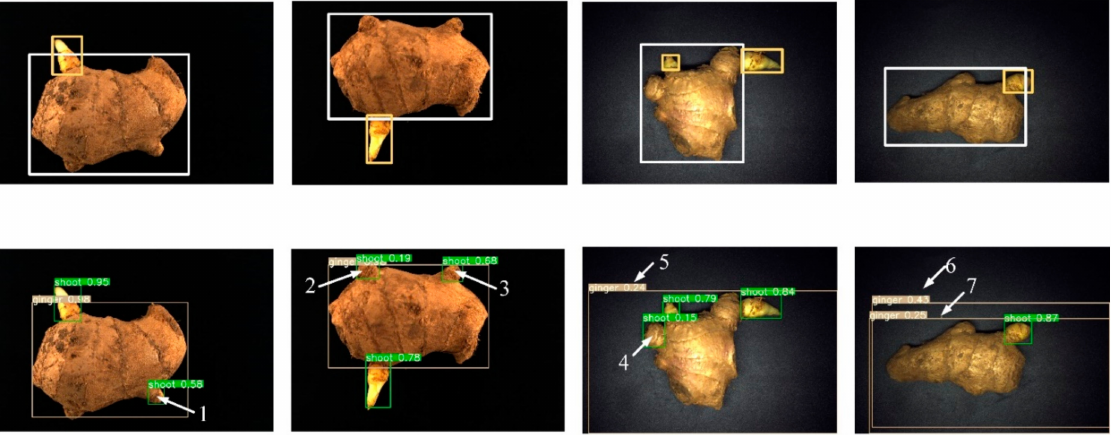
Figure 12. Wrong recognition results of